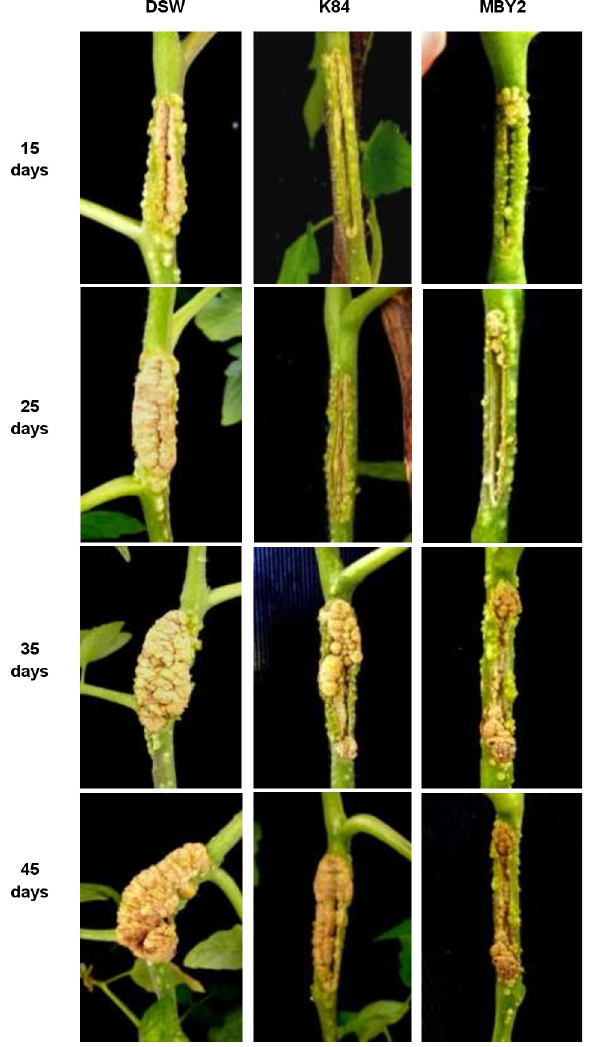
Fig 5. Antagonistic activity in planta of B . velezensi s MBY2 on tomato plants. Stems of tomato ( Solanum lycopersicum cv Heinz) plants were pre-infected with A . fabrum C58 and subsequently treated with B . velezensis isolate MBY2, with A . radiobacter biocontrol strain K84 as positive or with distilled sterile water (DSW) as negative control. Tumor proliferation was followed for up to 70 days post-inoculation. For each treatment three plants were used in one representative experiment.